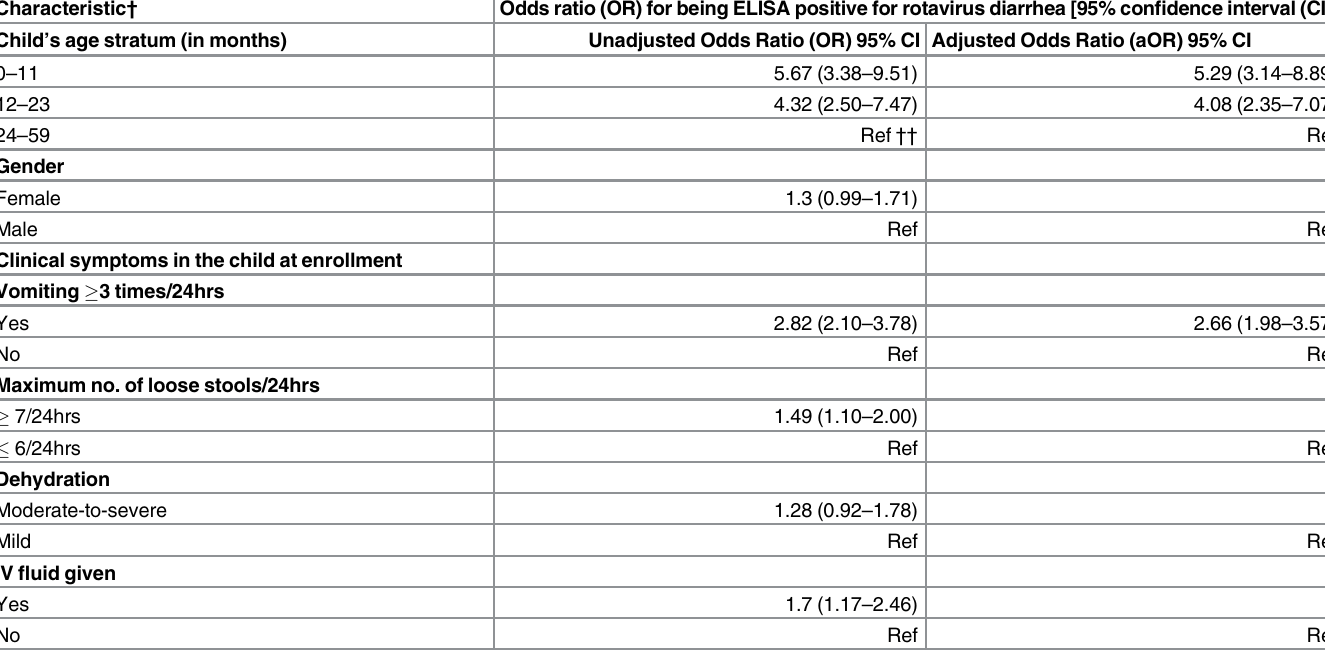
Table 3. Crude and adjusted odds ratios of factors associated with rotavirus among children < 5 years of age with non-dysenteric MSD, western Kenya, 2008 – 2012. Characteristic